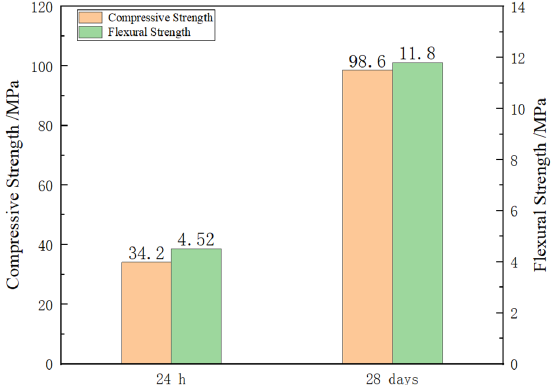
Figure 10. Compressive and Flexural Strength.